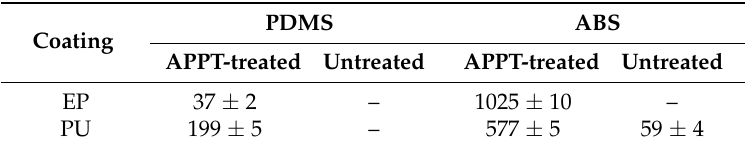
APPT/PU and epoxy ( b ) PDMS + APPT/EP.